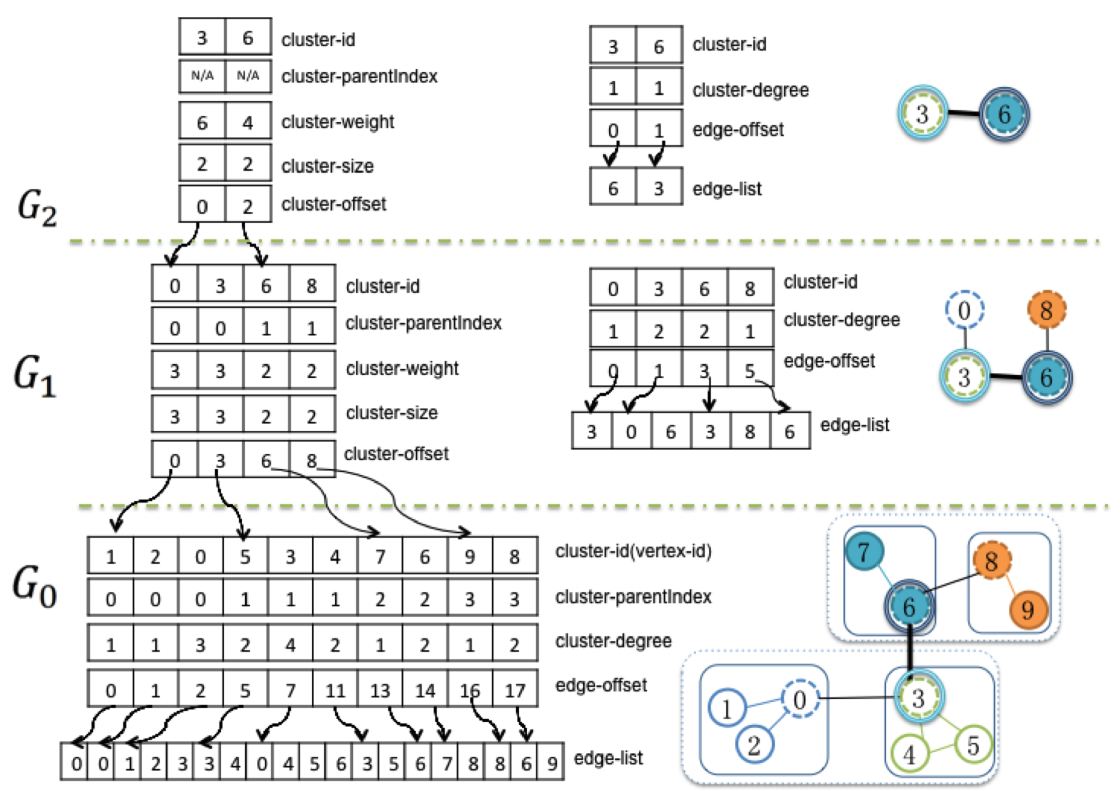
Figure 3. An example of the GPU memory organization of three-levels of graphs. Node-link diagrams (right) show the corresponding level graphs. Several data arrays (left) are stored in GPU memory to represent these graphs. In this figure, G 0 is the original graph, which is partitioned into four sub-graphs. G 1 is the coarsened graph of the original graph, and is partitioned into two sub-graphs. G 2 is the coarsest graph.